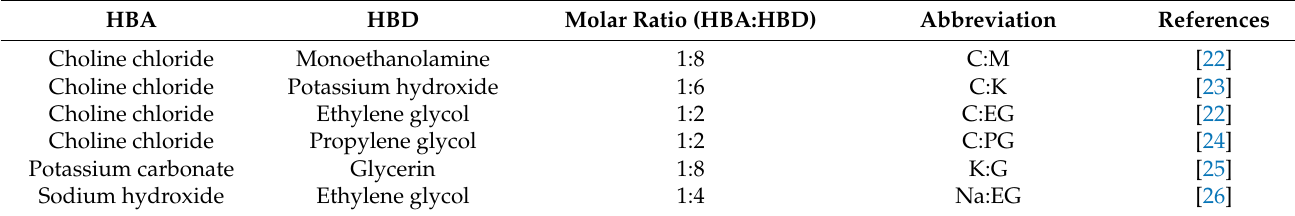
Table 1. The composition of